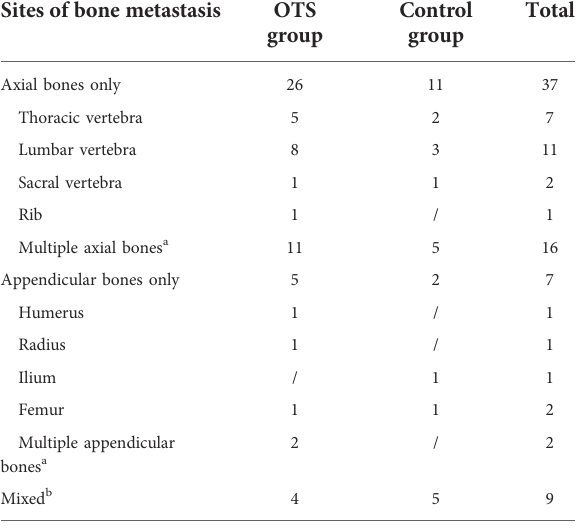
TABLE 2 Distribution of bone metastasis